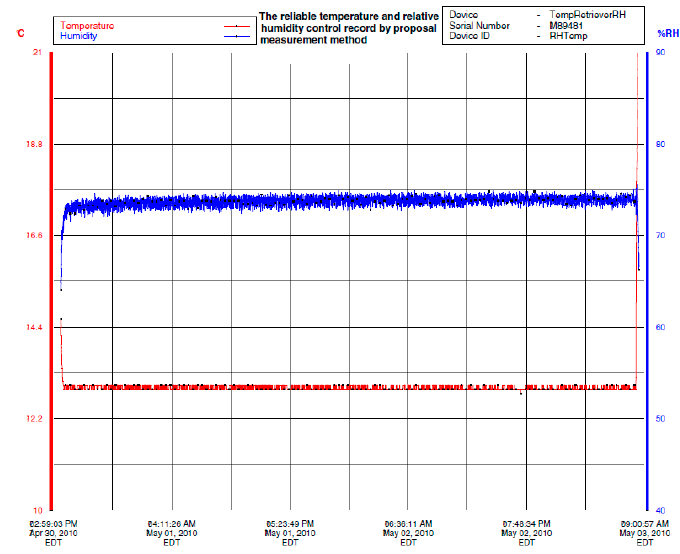
Figure 8. The process control results of temperature and relative humidity based on the improved psychrometer.